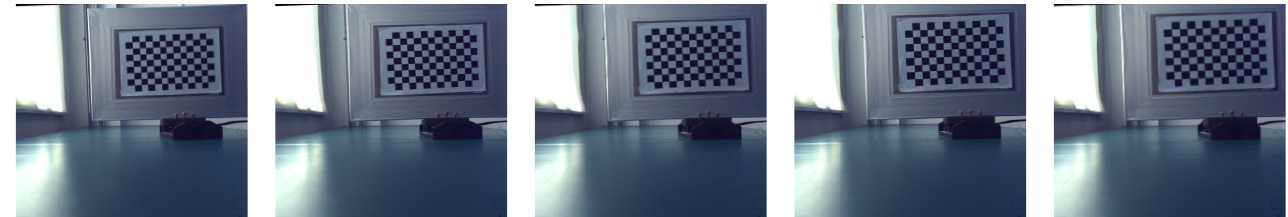
Figure 7. Left view of sample library production and target image acquisition.